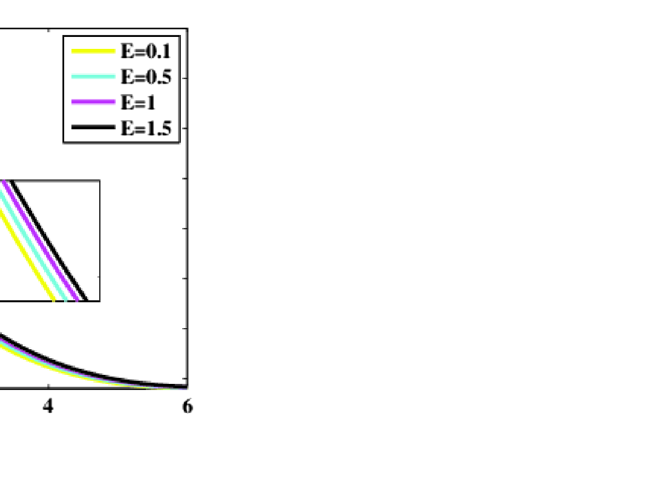
Figure 18. Plots of φ(ϒ) for E .